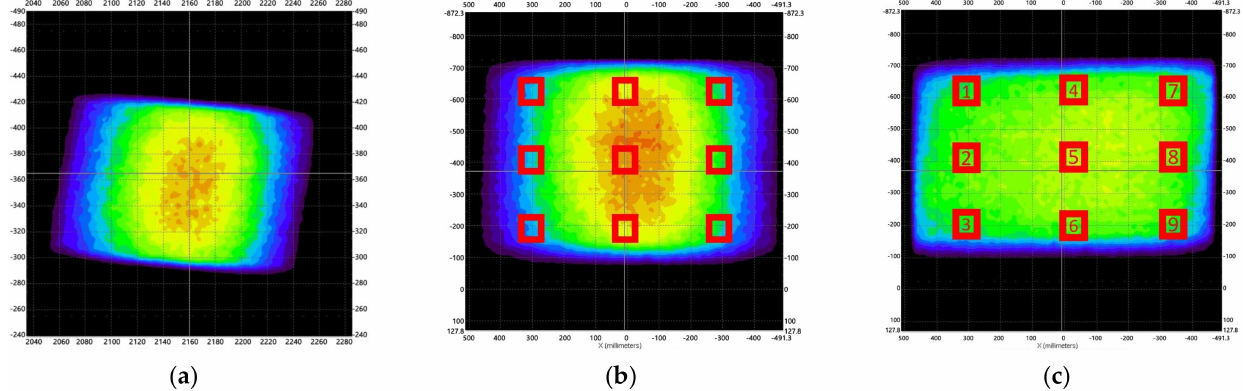
Figure 21. Illuminance map of the target plane before any correction ( a ), with an incident plane shape correction only ( b ), and with a shape correction and an illuminance regression ( c ).